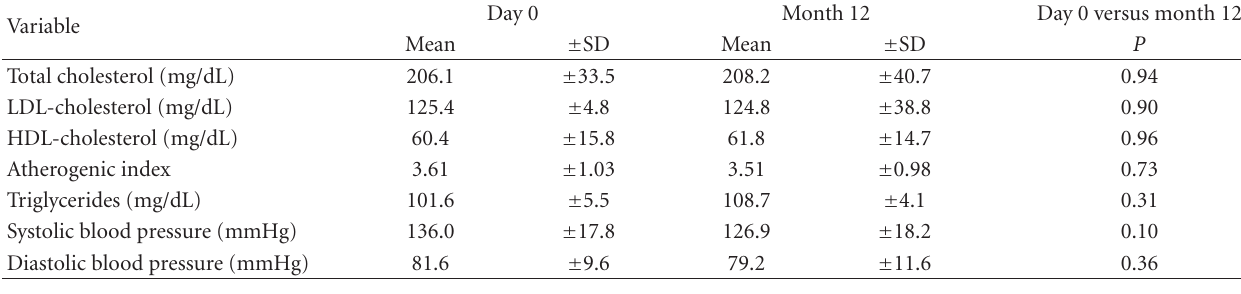
Table 2: Changes in the lipid profile and blood pressure levels in 34 patients undergoing anti-TNF-alpha-adalimumab therapy due RA refractory to conventional DMARDs.